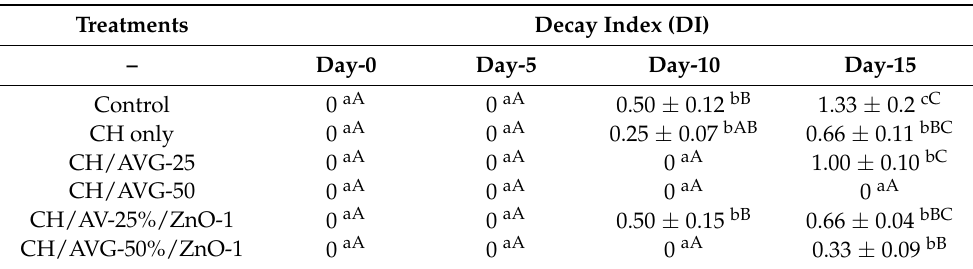
Table 2. Decay index (DI) of the treated and untreated pineapple fruits during ambient storage of 15 days. Treatments Decay Index (DI) – Day-0 Day-5 Day-10 Day-15